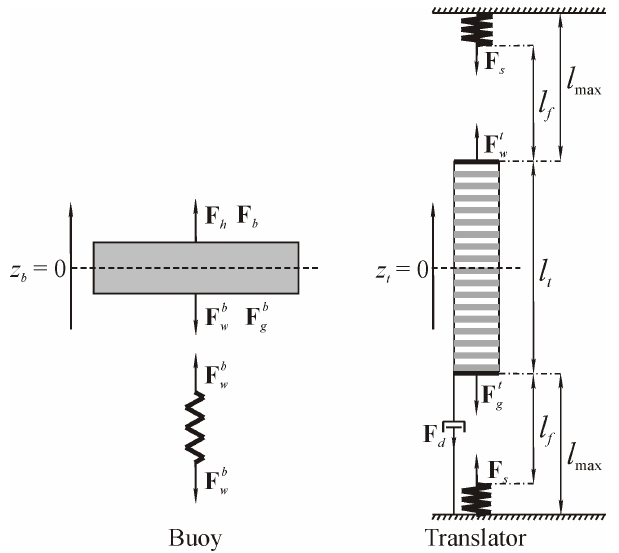
Figure 6. Forces acting on the buoy and translator. Reproduced with permission from [32]. Table 4. WEC modeling parameters. Reproduced with permission from